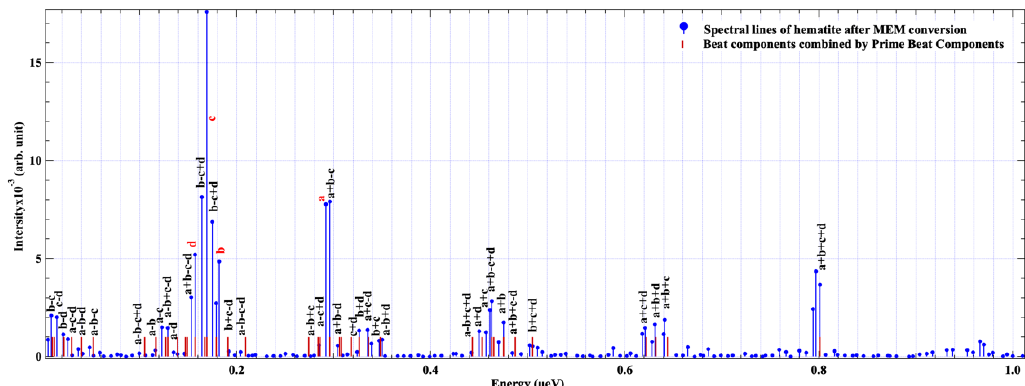
Figure 5. The PBCs and 40 beat components of 57 Fe 2 O 3 powder at room temperature acquired by PBCs extraction method (the blue lines mean the spectral lines after MEM conversion; the red lines mean the beat components that are combined by PBCs; the combinations are labeled above the spectral lines assigned). Table 1. Forty beat components generated by PBCs and contrast with the spectral lines from the QB spectrum.